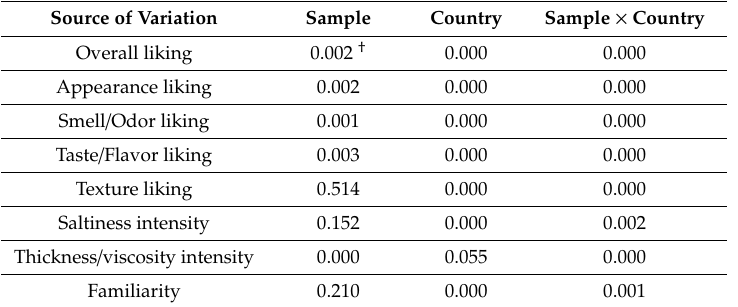
Table 3. Influence of sample, country, and sample × country interaction e ff ects on the ratings of liking, intensity, and familiarity of salad dressing